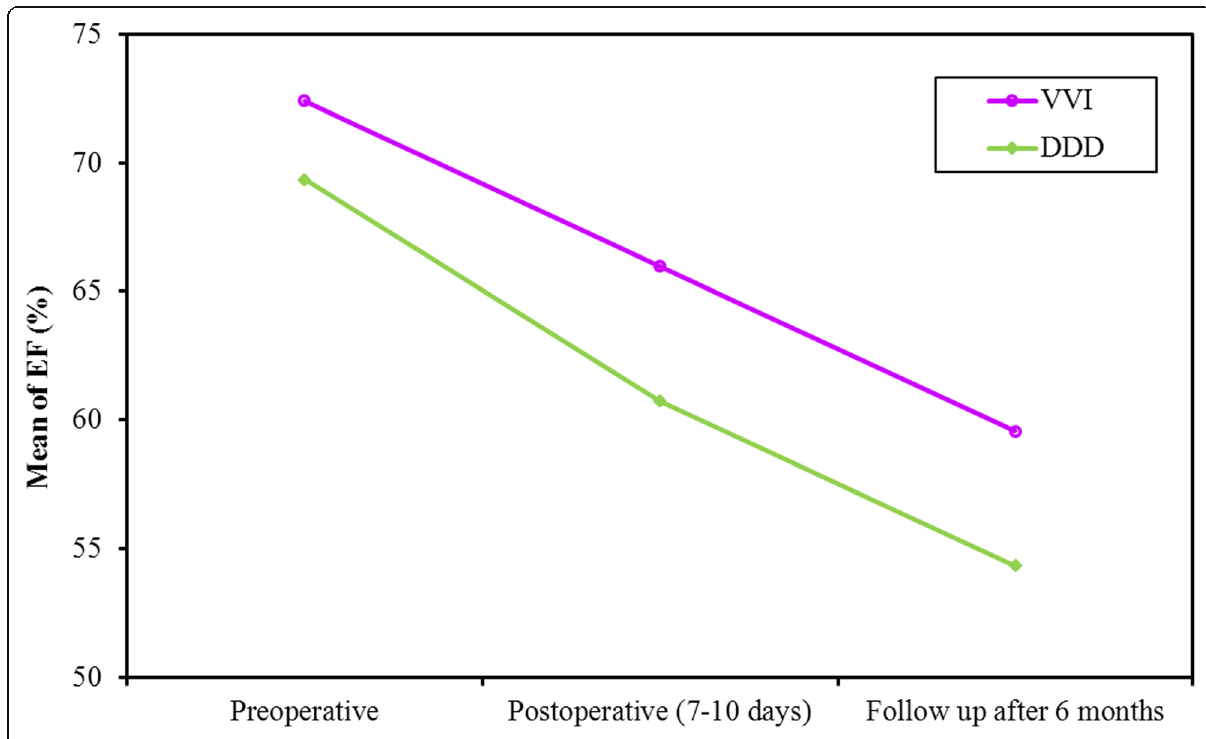
Fig. 6 Comparison between the different periods according to EF (%) in each